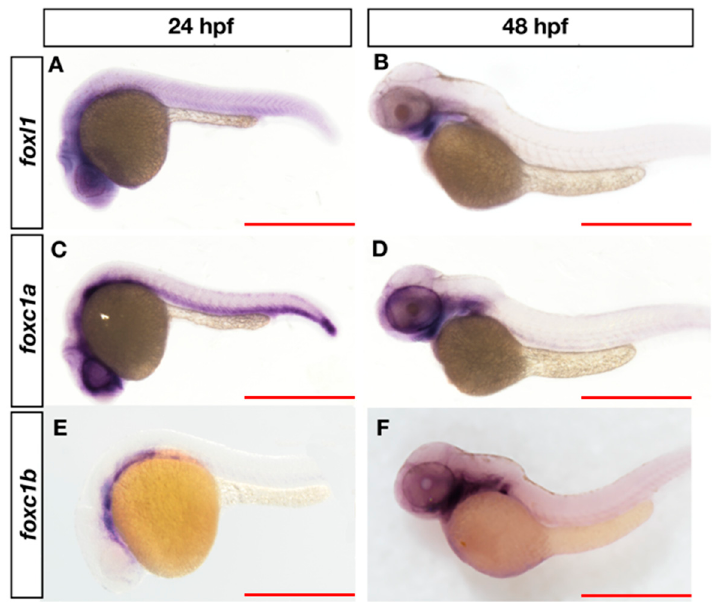
Figure 3. Expression of foxl1 , foxc1a, and foxc1b in wildtype zebrafish at 24 and 48 hpf. At 24 hpf, foxl1 is expressed at in the brain and trunk ( A ), similar to foxc1a ( C ), while foxc1b is observed in the ventral head/brain regions ( E ). At 48 hpf, all three forkhead genes are expressed in the pharyngeal arches ( B , D , F ). Scale bars are 500 µm.